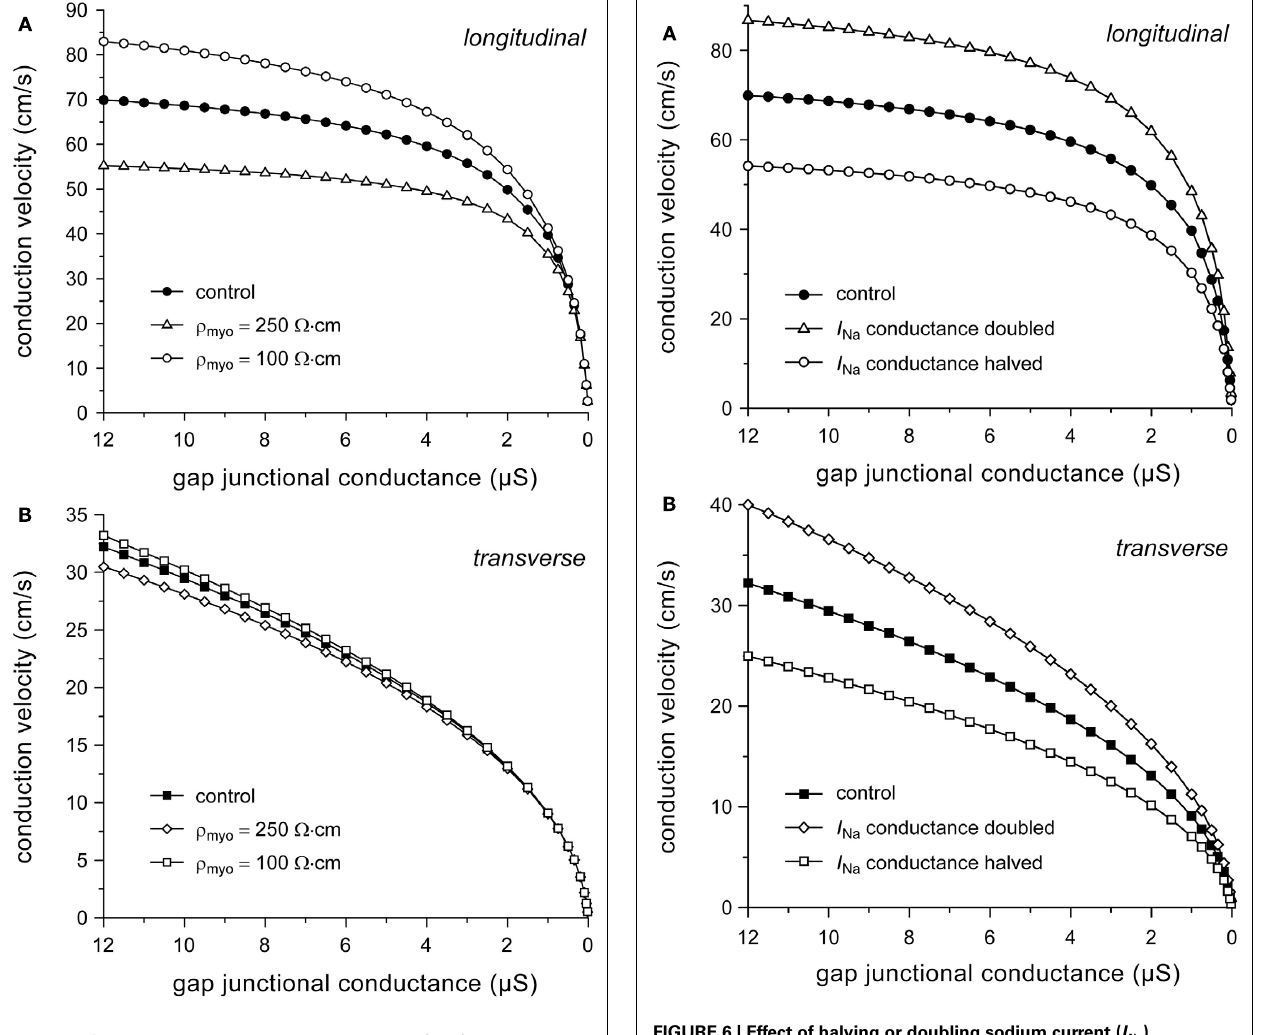
FIGURE 5 | Dependence on myoplasmic resistivity ( ρ myo ) of relationship between (A) longitudinal or (B) transverse conduction velocity and gap junctional conductance.